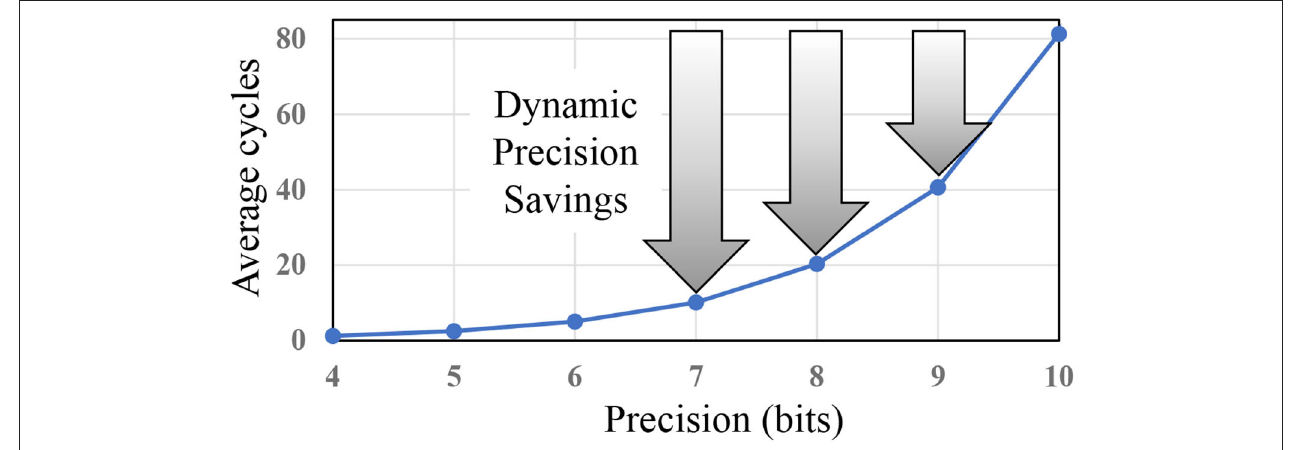
FIGURE 1 | Dynamic precision, or using lower precision whenever possible, can give huge boost in efficiency for stochastic computing